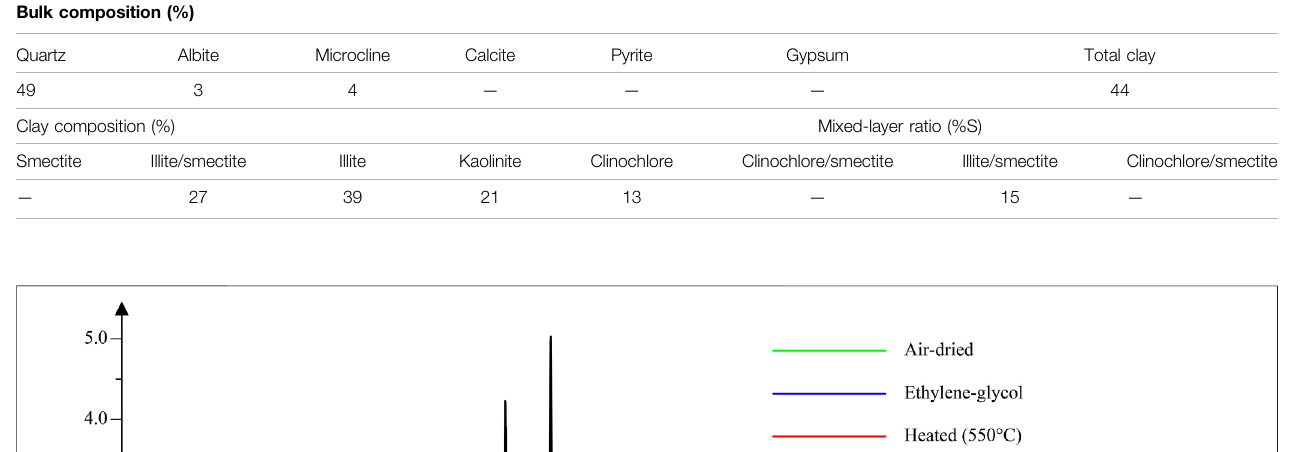
TABLE 2 | Bulk-rock and clay mineral compositions of fault gouge sample DC4-1.